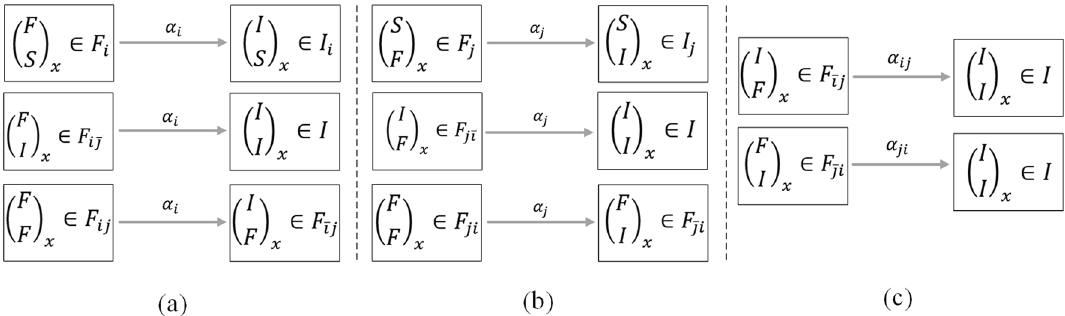
Figure 7. Losing active forwarding state with a period of time: ( a ) information i ; ( b ) information j ; ( c ) complex case of information i and j .